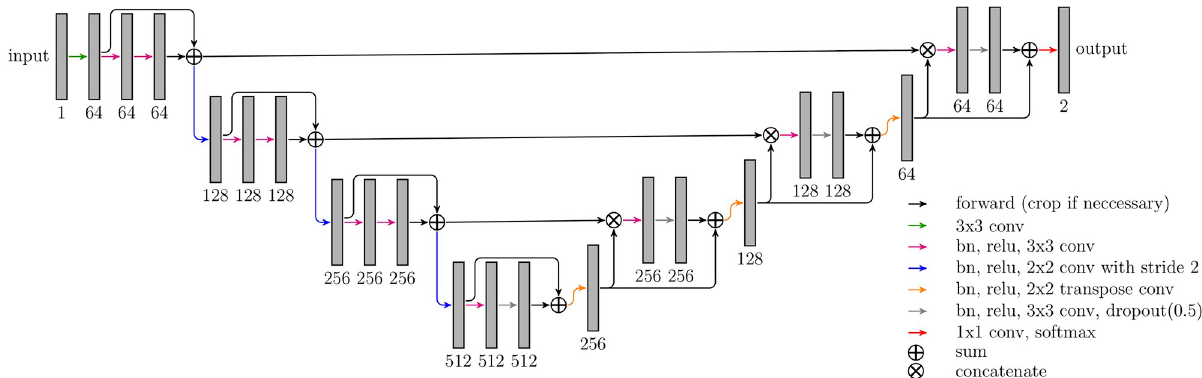
Fig 2. Architecture of CNN models employed in the Liver-Net method. The numbers denote the feature map count.